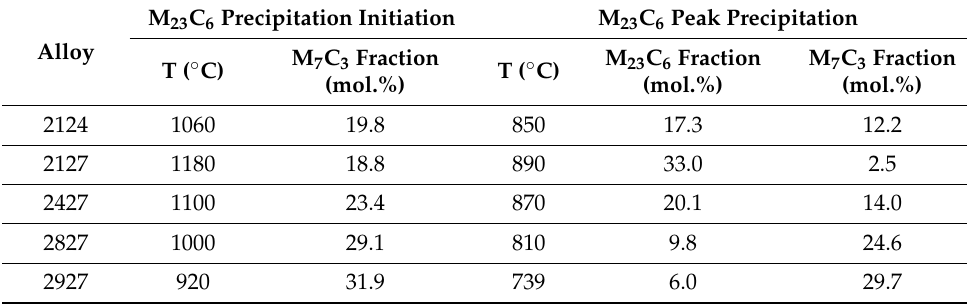
Table 2. Precipitation behaviors of M 7 C 3 and M 23 C 6 by ThermoCalc calculation